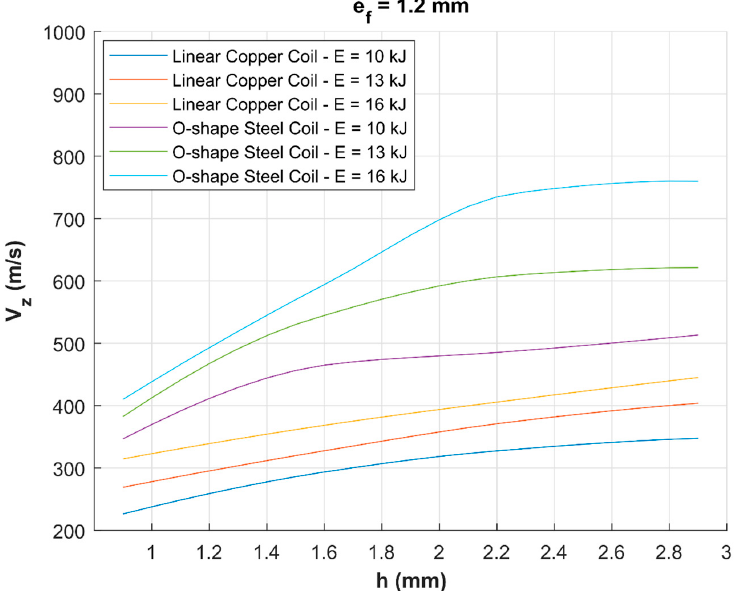
Figure 15. Impact velocities comparison between the steel O-shape coil and linear copper coil ( e f = 1.2 mm)